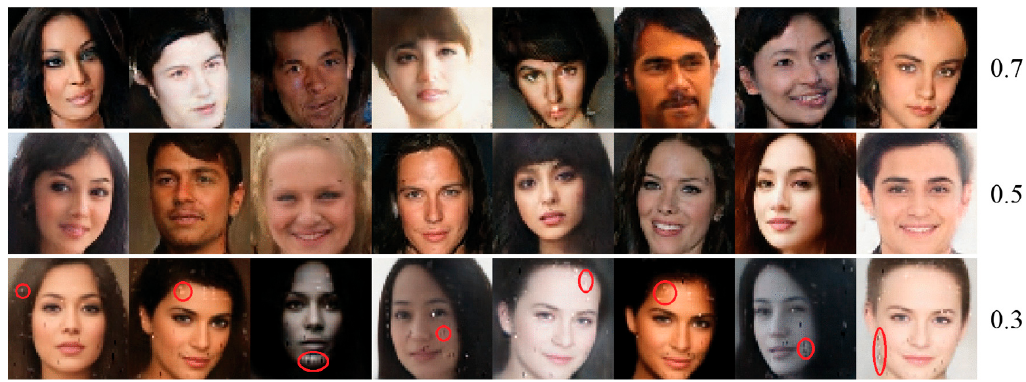
Figure 4. Generated images with different values of the hyper parameter γ (some noise-like regions are marked with red).